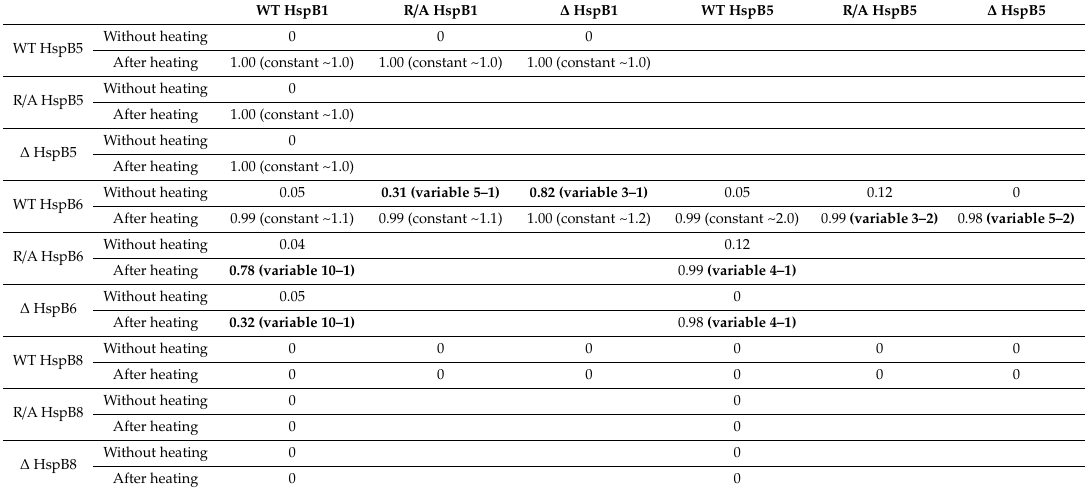
Table 1. Correlation coe ffi cient and molar ratio HspB1 / HspB5, HspB1 / HspB6 and HspB5 / HspB6 in heterooligomers (in brackets). WTHspB1 R / AHspB1 ∆ HspB1